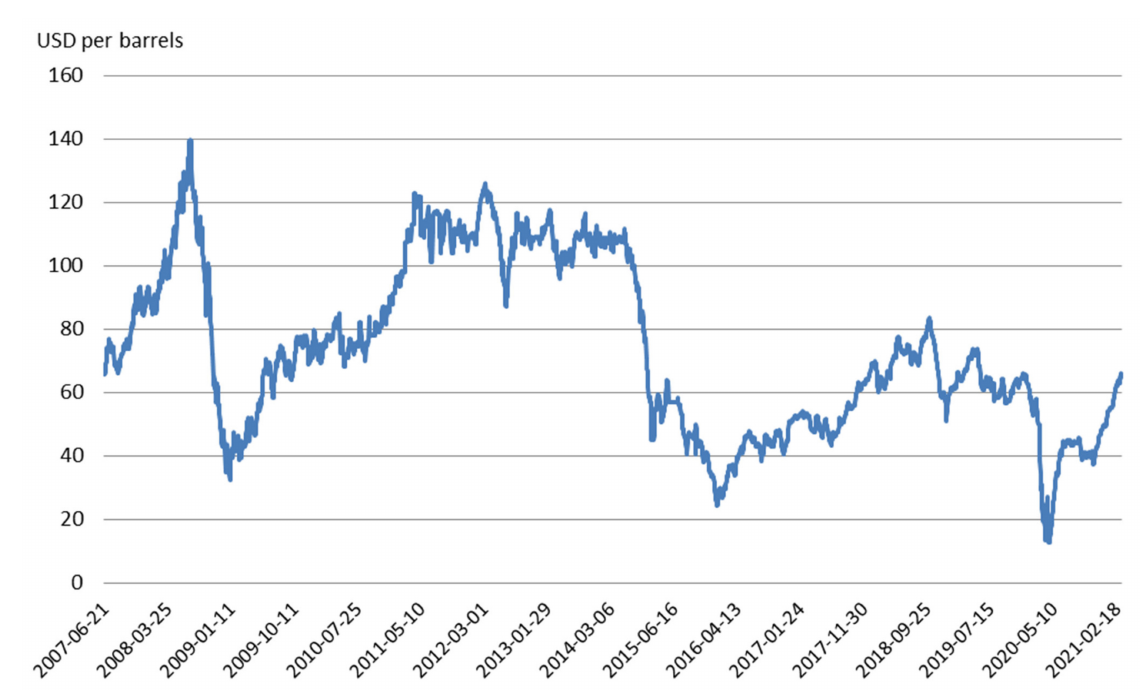
Figure 7. Crude oil prices at Brent, London, in the years 2005–2021